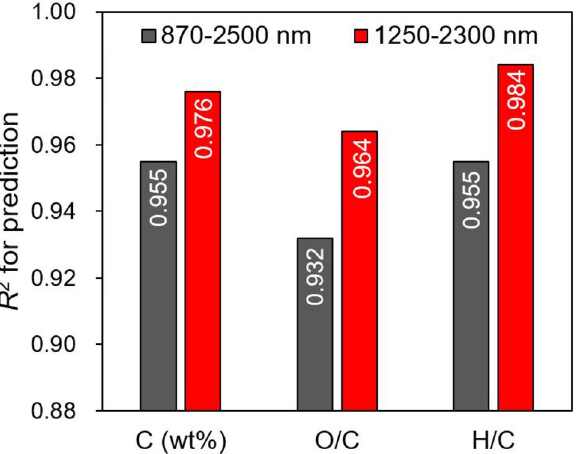
Figure 5. Comparison of coefficients of determination for prediction of PLSR models established in NIR spectral region of 870–2500 nm (full range) and 1250–2300 nm (selected in this study).